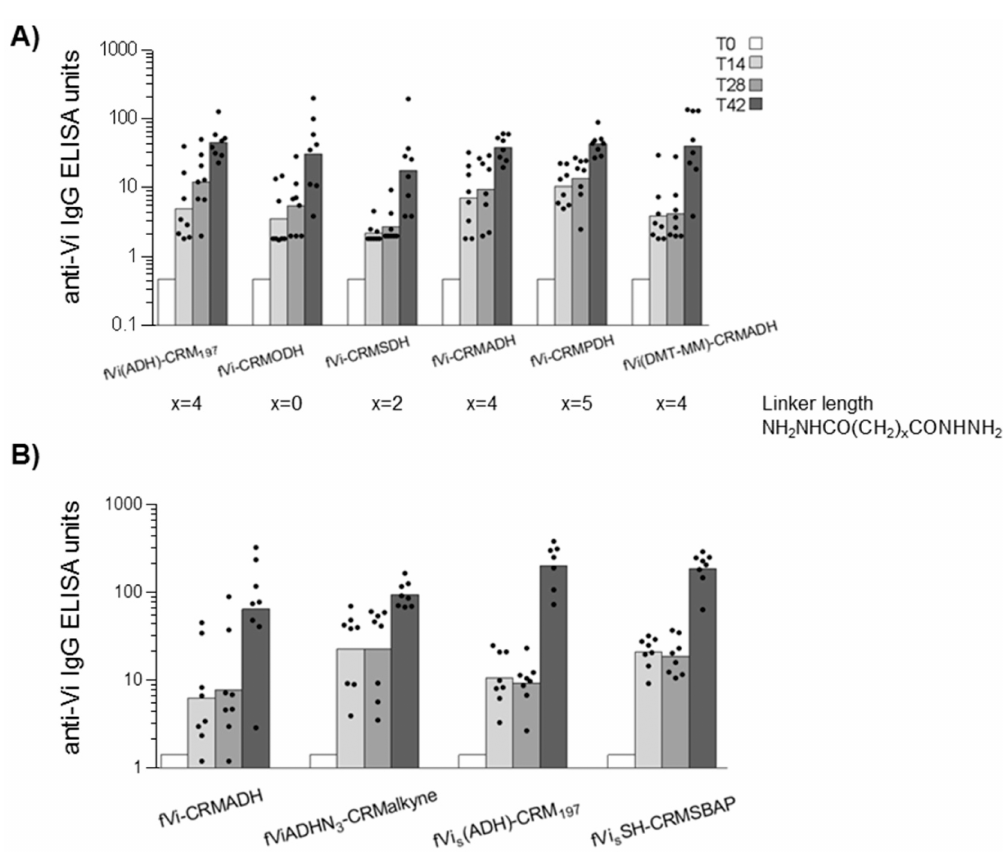
Fig 6. Influence of conjugation chemistry (Table 3) on the immunogenicity of fVi-CRM 197 conjugates in mice: anti-Vi IgG ELISA titres. Five weeks old CD1 mice were immunizedat days 0 and 28 at 1 μ g Vi/dose in two separate studies (A and B). Bars representthe geometricmean ELISA units of the group in log scale, individualanimalsare representedby the scatter